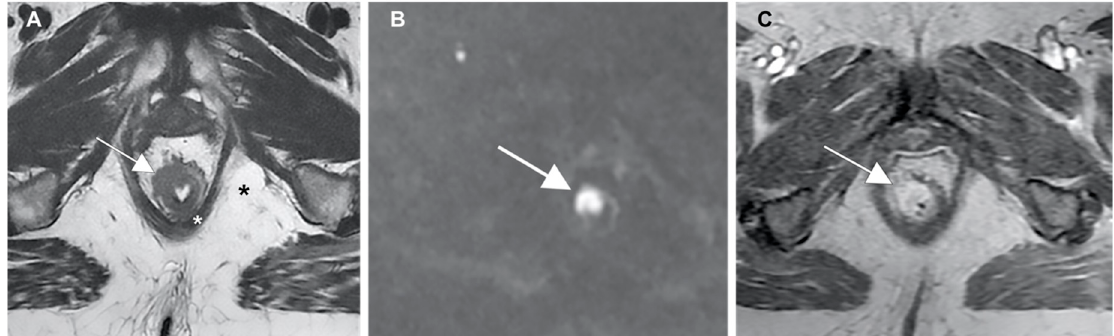
Figure 3. ( A ) Anal cancer captured using MR imaging, showing (white arrows) a higher signal intensity than the mucosal and submucosal layers; ( B ) restriction of proton diffusion at the DWI sequence; and ( C ) post-contrast enhancement after gadolinium injection